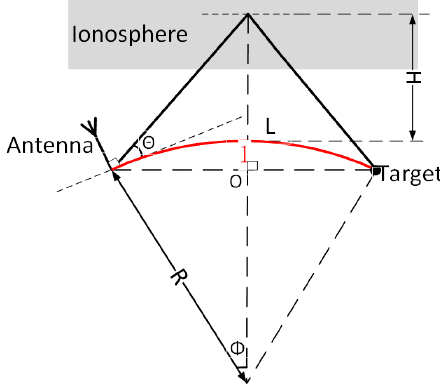
Figure 2. Mathematical model considering the Earth’s curvature.